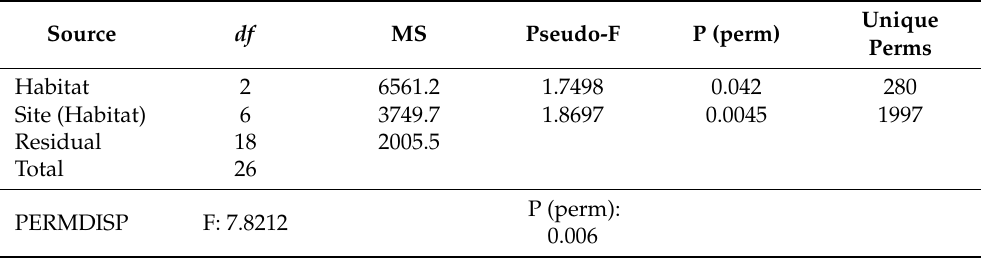
Table 6. Permutational multivariate analysis of variance (PERMANOVA) on scavenging ben- Table 6 . Permutational multivariate analysis of variance (PERMANOVA) on scavenging benthope- thopelagic macrofauna assemblages. lagic macrofauna assemblages.